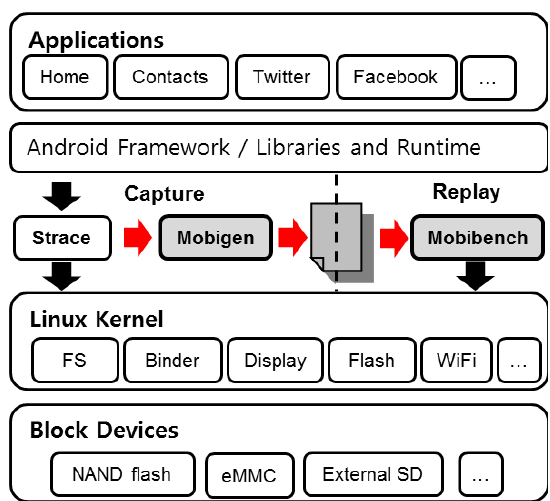
Figure 5. Structure of